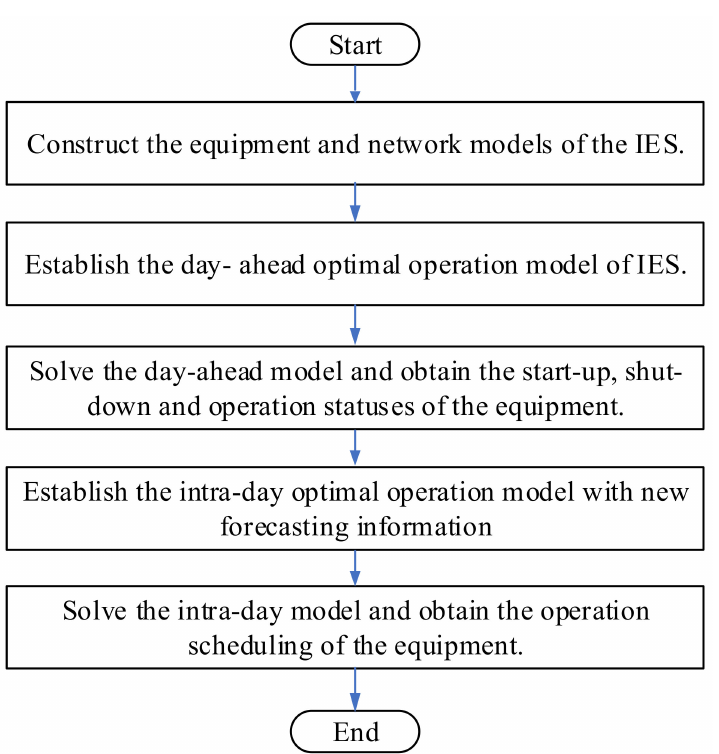
Figure 8. Flowchart of day-ahead and intra-day collaborative optimization of an IES.